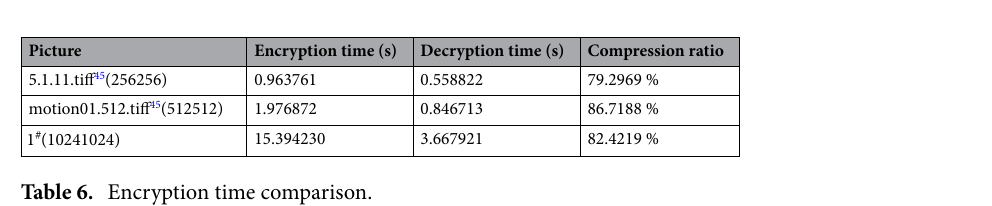
Table 5. The experimental results show that the information entropy of both ciphertext images is above 7.998, which is close to the theoretical value of 8, indicating that the encryption algorithm has a good encryption effect and can better resist the information entropy attack.